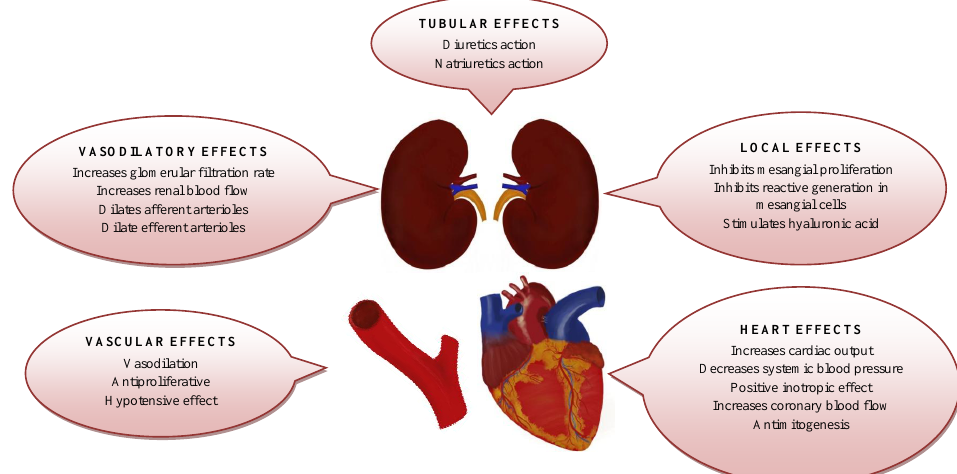
Figure 1. Effects of ADM on kidney and cardiovascular